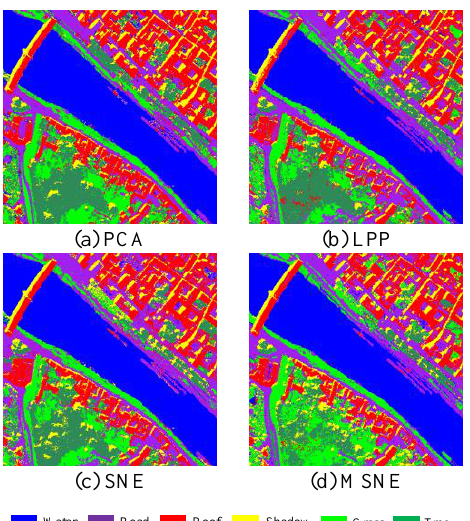
Third row: shape feature images. Fig. 2. Multiple features of the Pavia city data set.